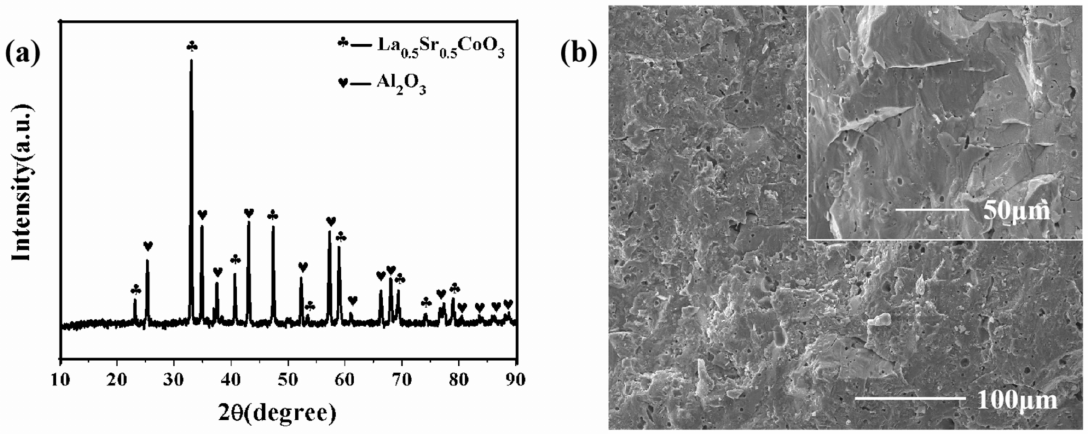
Figure 2. ( a ) X-ray diffraction patterns of magnetic ceramic. ( b ) Surface topography of magnetic